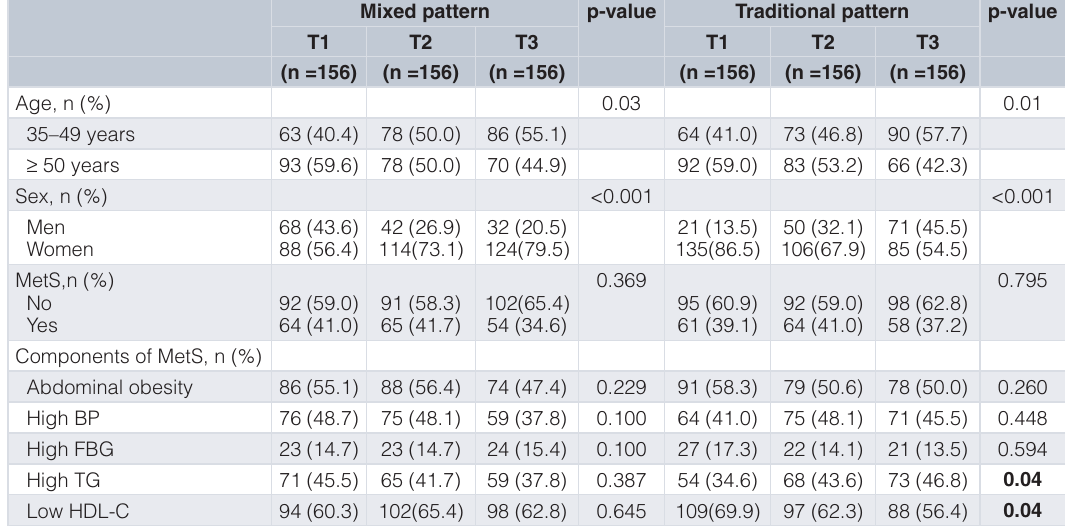
Table 4. The distribution of age, sex, metabolic syndrome (MetS) and its components according to tertiles of dietary pattern scores. Mixed pattern p-value Traditional